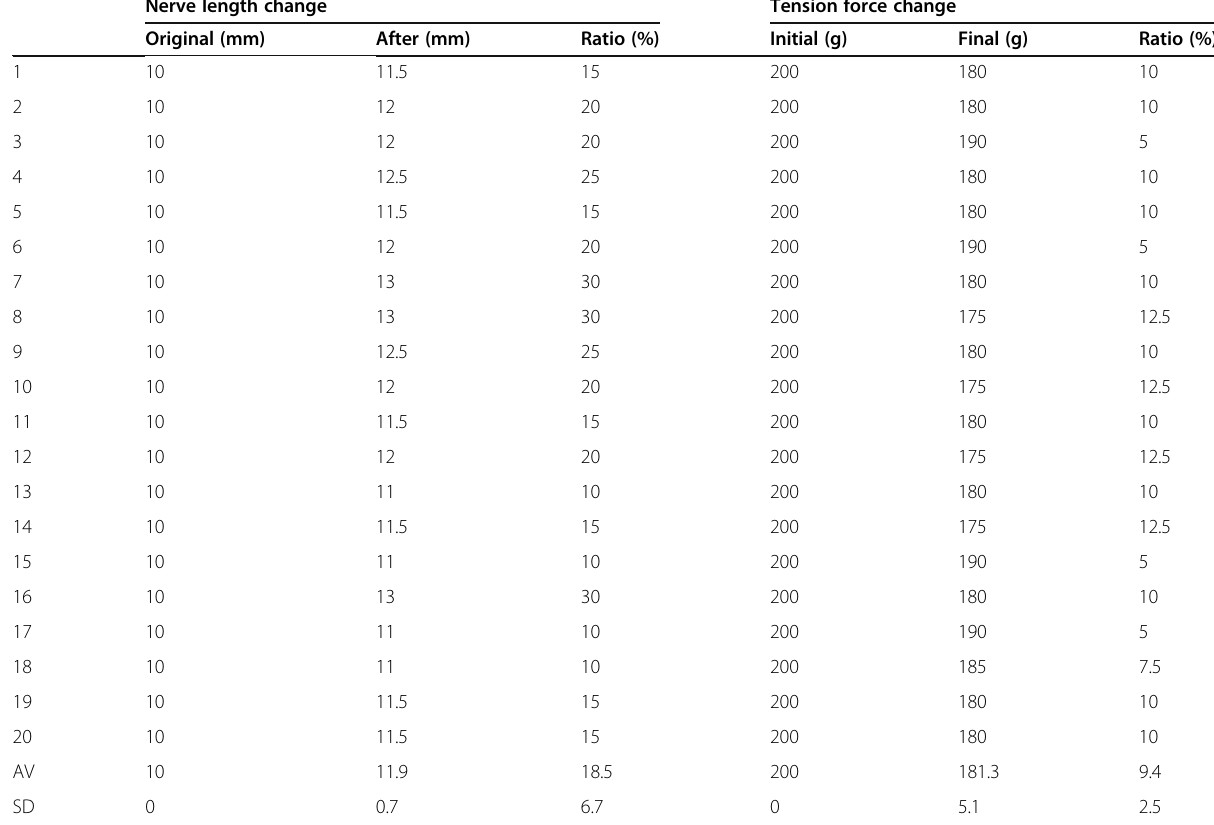
Table 1 Measurement of nerve elongation and tension force change after tension injury Nerve length change Tension force